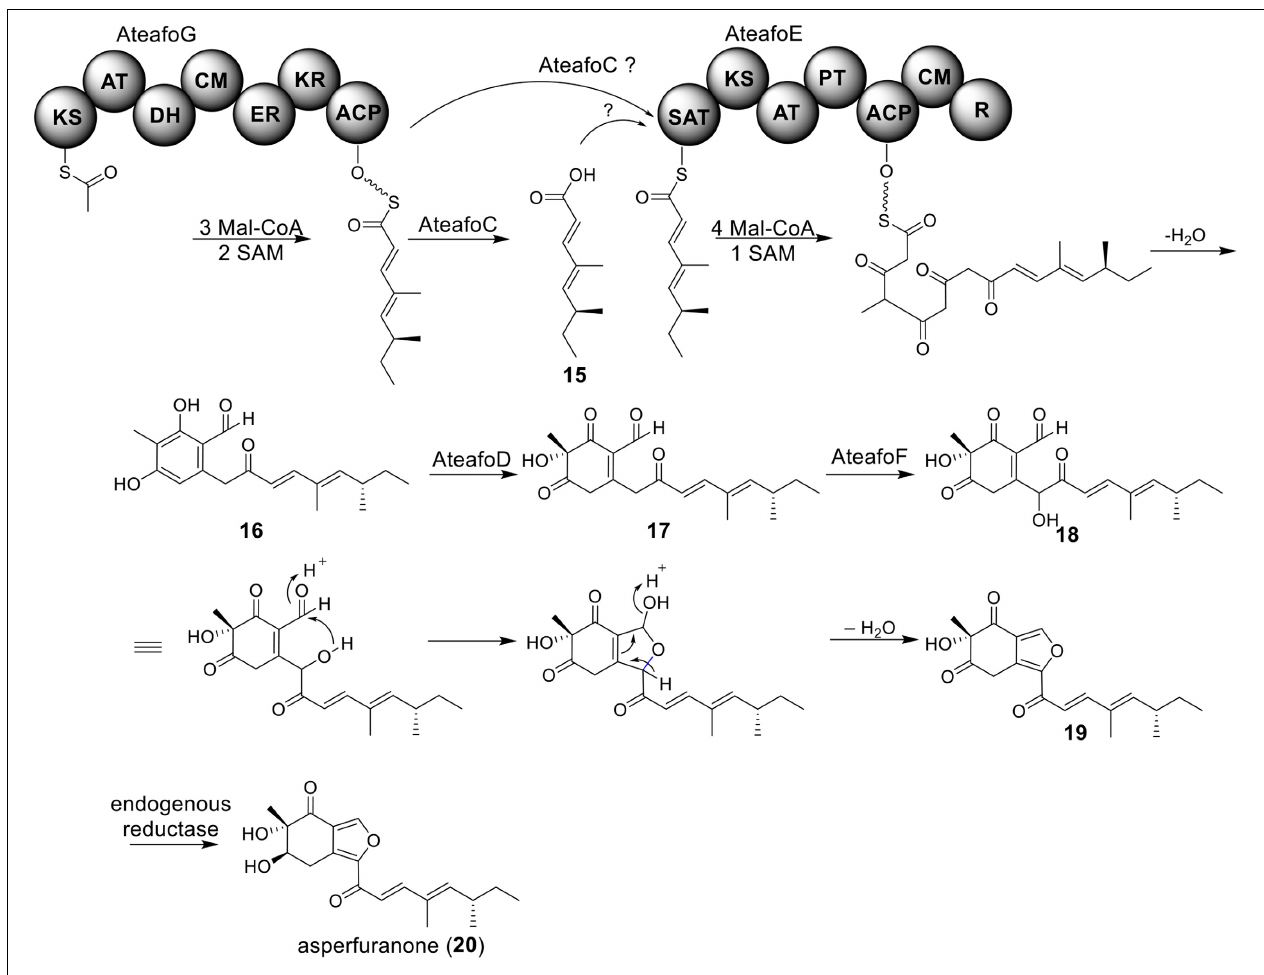
FIGURE 5 | Biosynthesis of asperfuranone in A. terreus